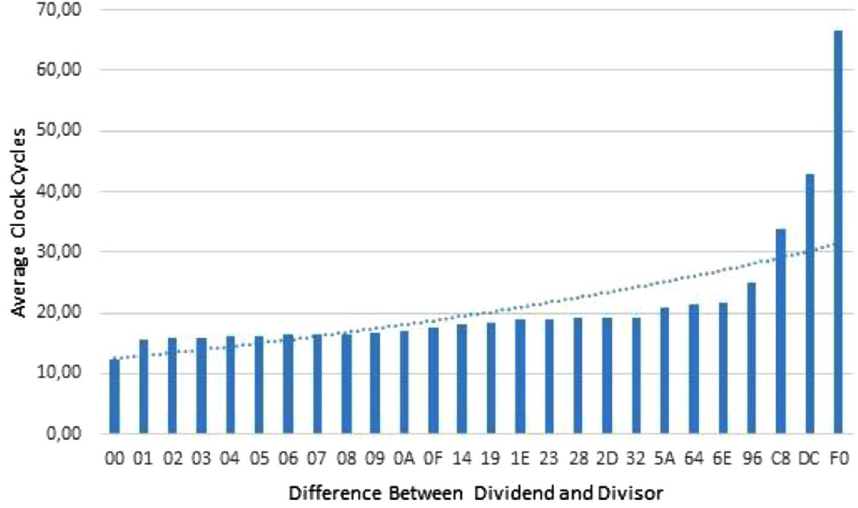
Figure 8. Clock performance analysis of the proposed USP-Awadhoot algorithm-based divider.